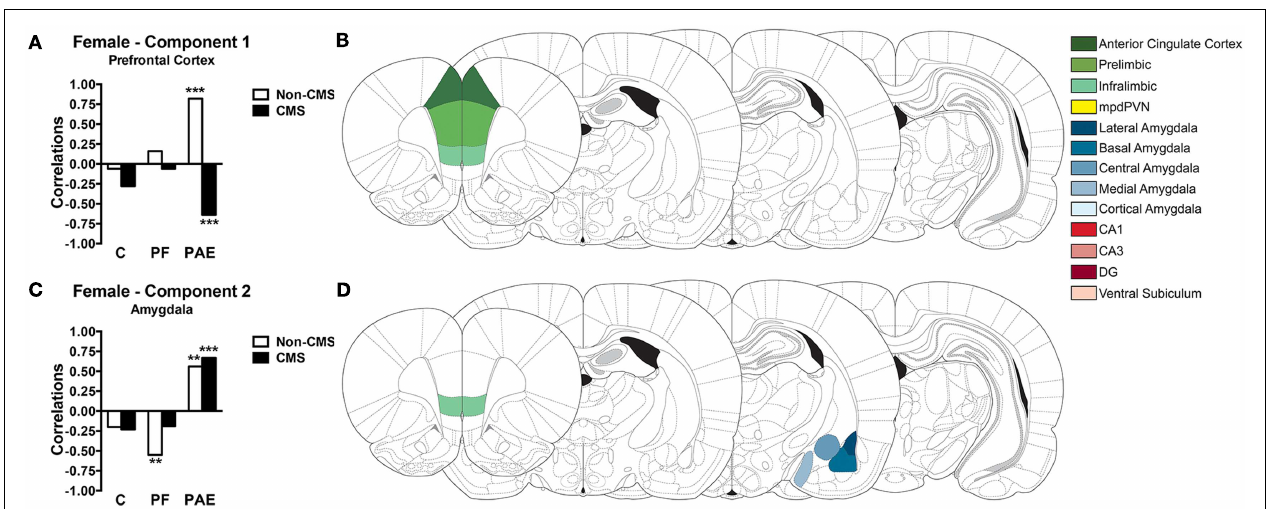
areas that contributes to each neural network (B,D) . Images were adapted from Ref. (46), *** p < 0.0001; ** p < 0.01. C, control; PF, pair-fed; and PAE, prenatal alcohol